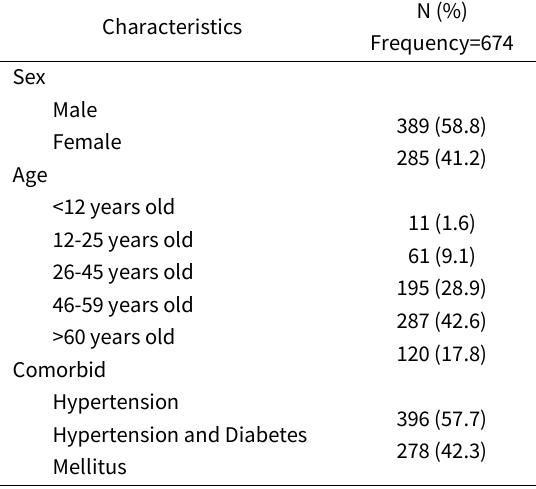
Table 2 . Cause of death in CAPD patients